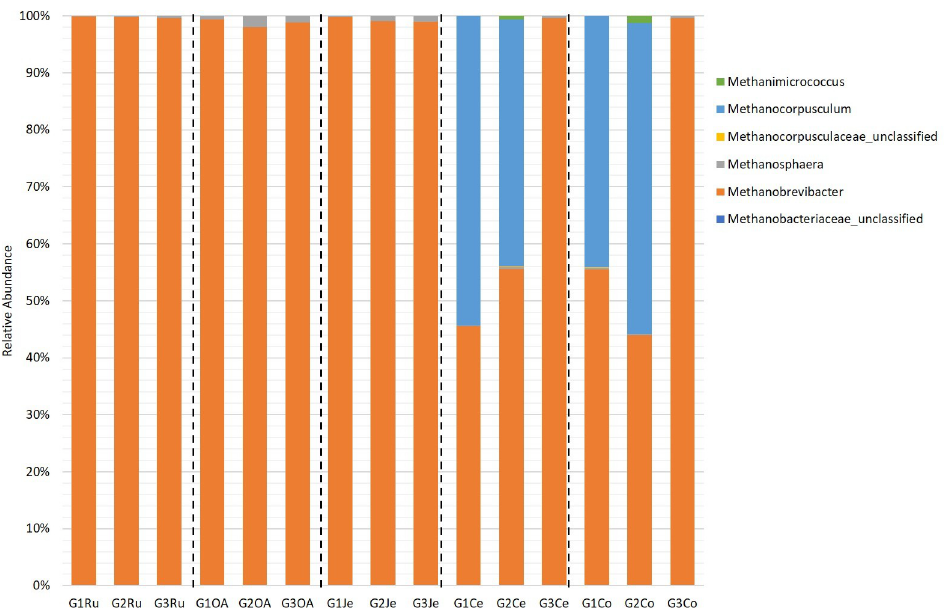
Fig 5. Distribution of the total archaeal genera in Capra hircus GITs. Ru: rumen; OA: omasum + abomasum; Je: jejunum; Ce: cecum; Co: colon; G: goat.